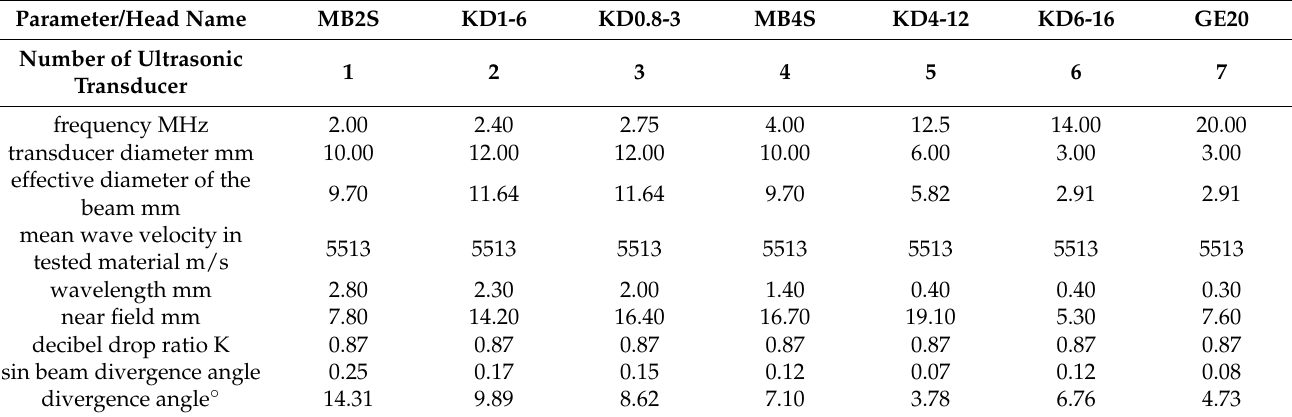
Table 2. Characteristics of the ultrasonic heads used in the study of basic acoustic parameters of Ti6Al4V-AM produced by additive manufacturing technology.